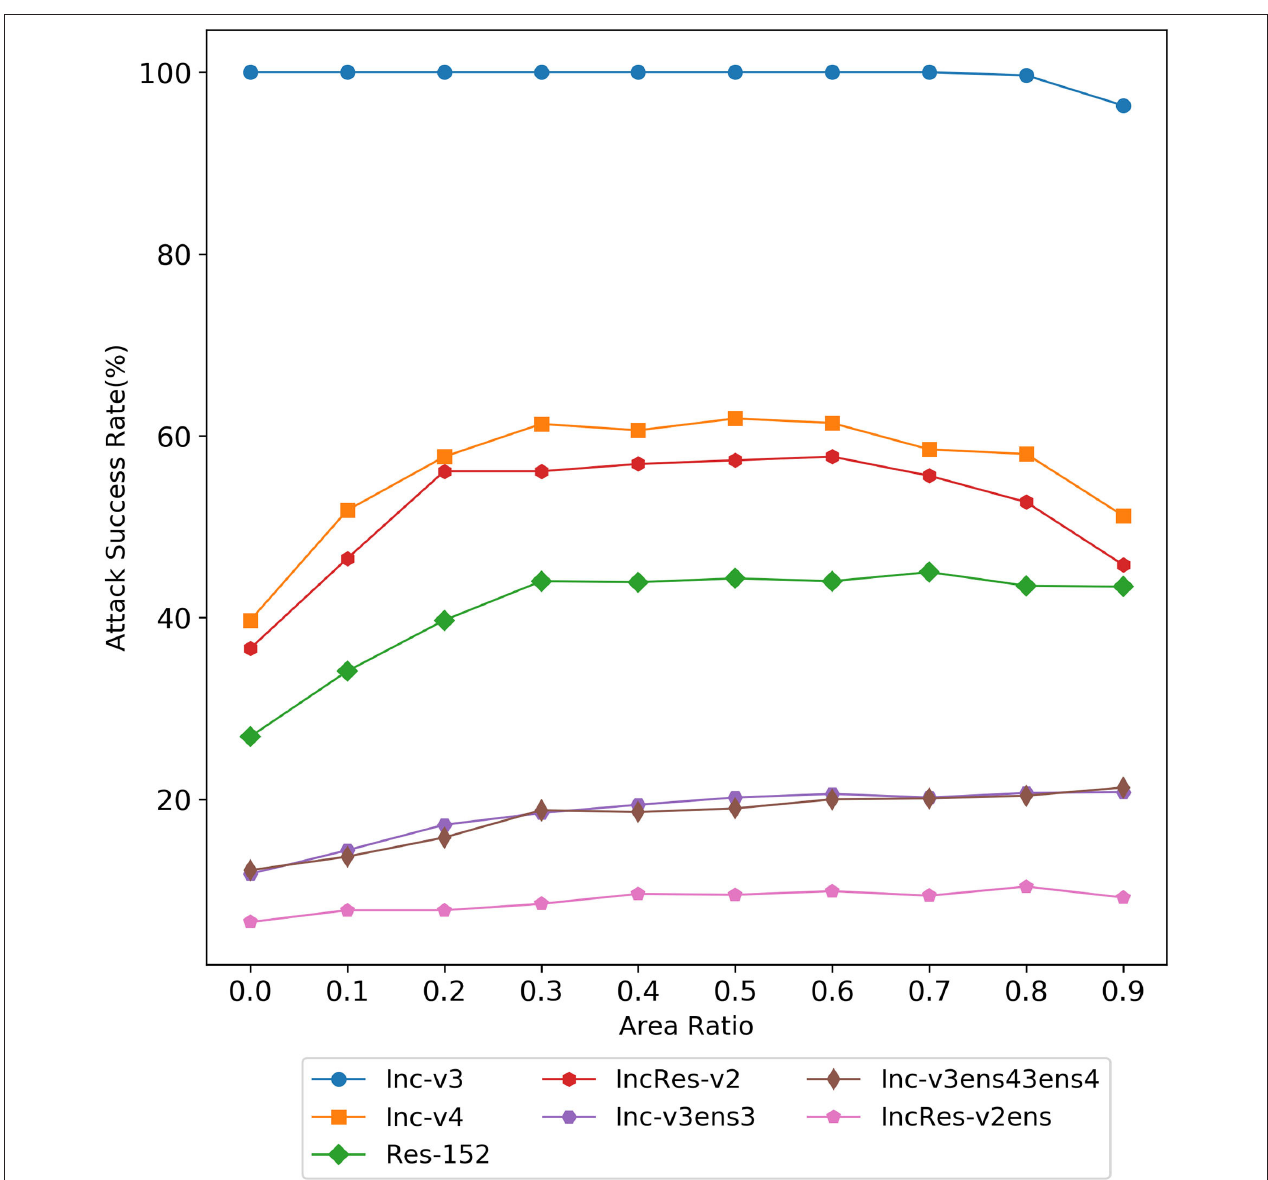
FIGURE 4 | The attack success rate (%) on seven models, the adversarial examples are crafted by Random Erasing Iterative Fast Gradient Sign Method (REI-FGSM) on Inc-v3 model with different area ratios.